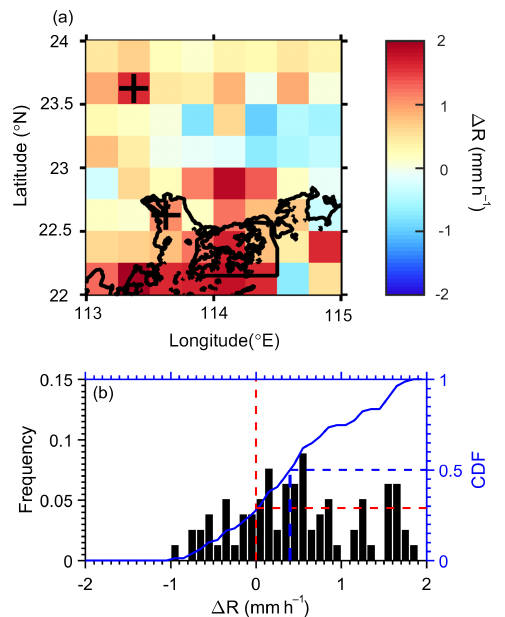
Figure 3. (a) Differences in precipitation intensity (polluted minus clean conditions, mmh − 1 ) over the PRD region. The black dots show grid boxes for which the difference exceeds the 95% signif- icance level ( p <0.05) according to the two-tailed Student’s t test. (b) Histogram showing the occurrence frequency (OF) and its cu- mulative distribution frequency (CDF) of precipitation intensity dif- ferences between polluted and clean conditions. The threshold value used to discriminate between clean and polluted atmospheric condi- tions corresponds to the lowest and highest third of the PM 10 con- centration averaged over the PRD region, respectively. The points where blue and red dashed lines cross correspond to cumulative probabilities of